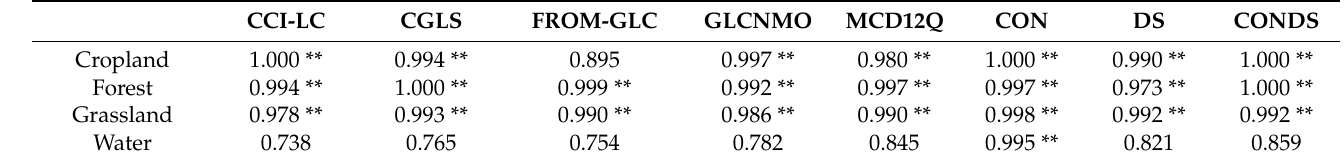
Figure 8. Correlation analysis and statistics of landcover products and fusion results and statistical data: ( a ) CCI-LC; ( b ) CGLS; ( c ) FROM-GLC; ( d ) GLCNMO; ( e ) MCD12Q; ( f ) CON; ( g ) DS; ( h ) CONDS. Table 5. Similarity test between landcover products and fusion results with statistical data.